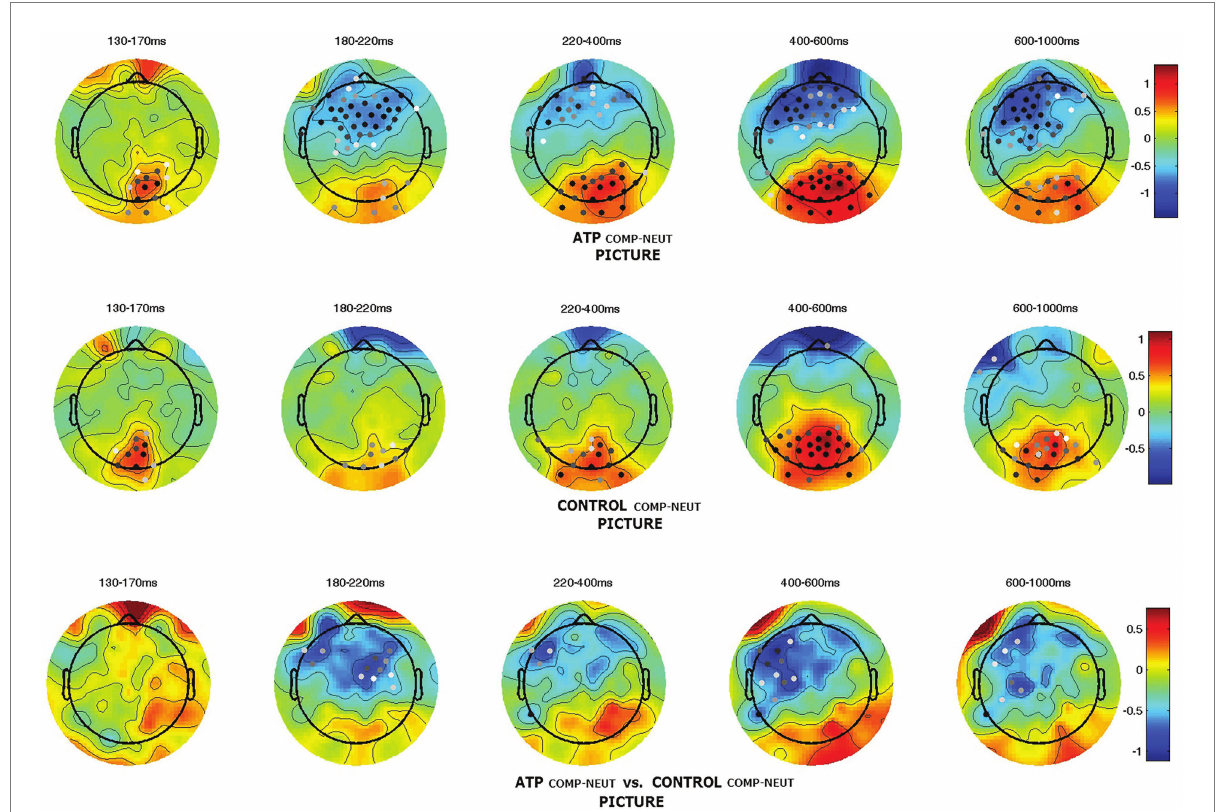
FIGURE 3 Group comparison of components in the compassion condition when viewing negative pictures. The patterns demonstrate that the Awareness Training Program (ATP) group had higher amplitudes (N400) in the left frontocentral region than the control group. Dots illustrate channels with significant differences ( p < 0.05), and darker dots indicate smaller p -values.